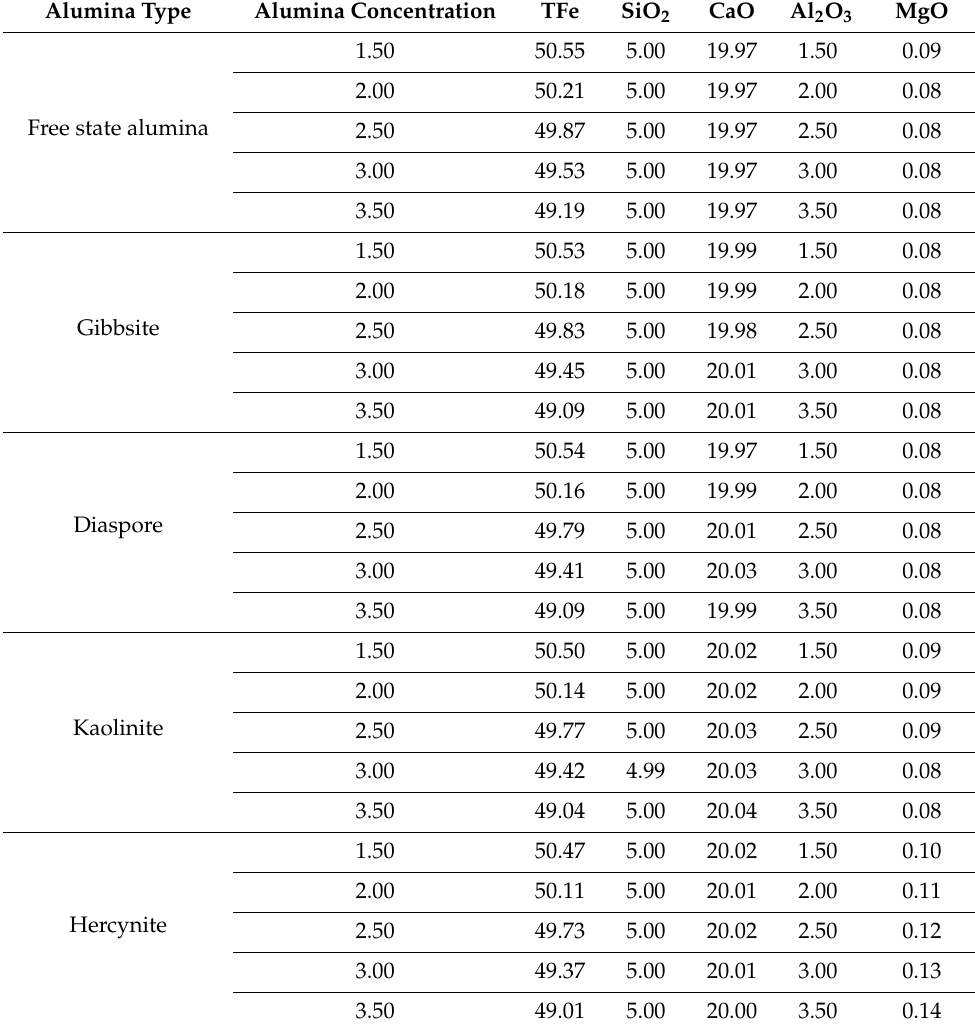
Table A4. Starting material compositions for the experiments of liquid phase fluidity (wt%). Alumina